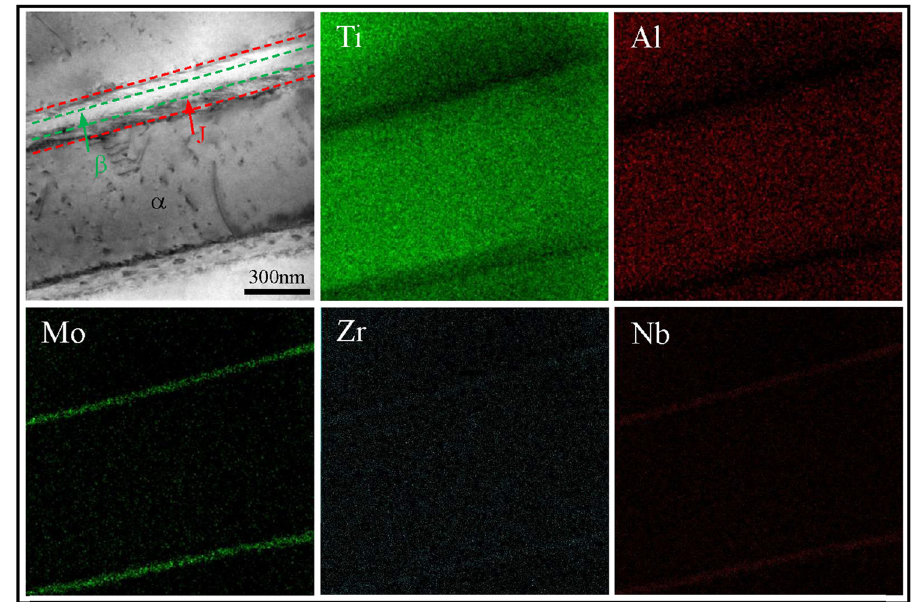
Figure 7: STEM element distribution diagram of forged Ti80 alloy.